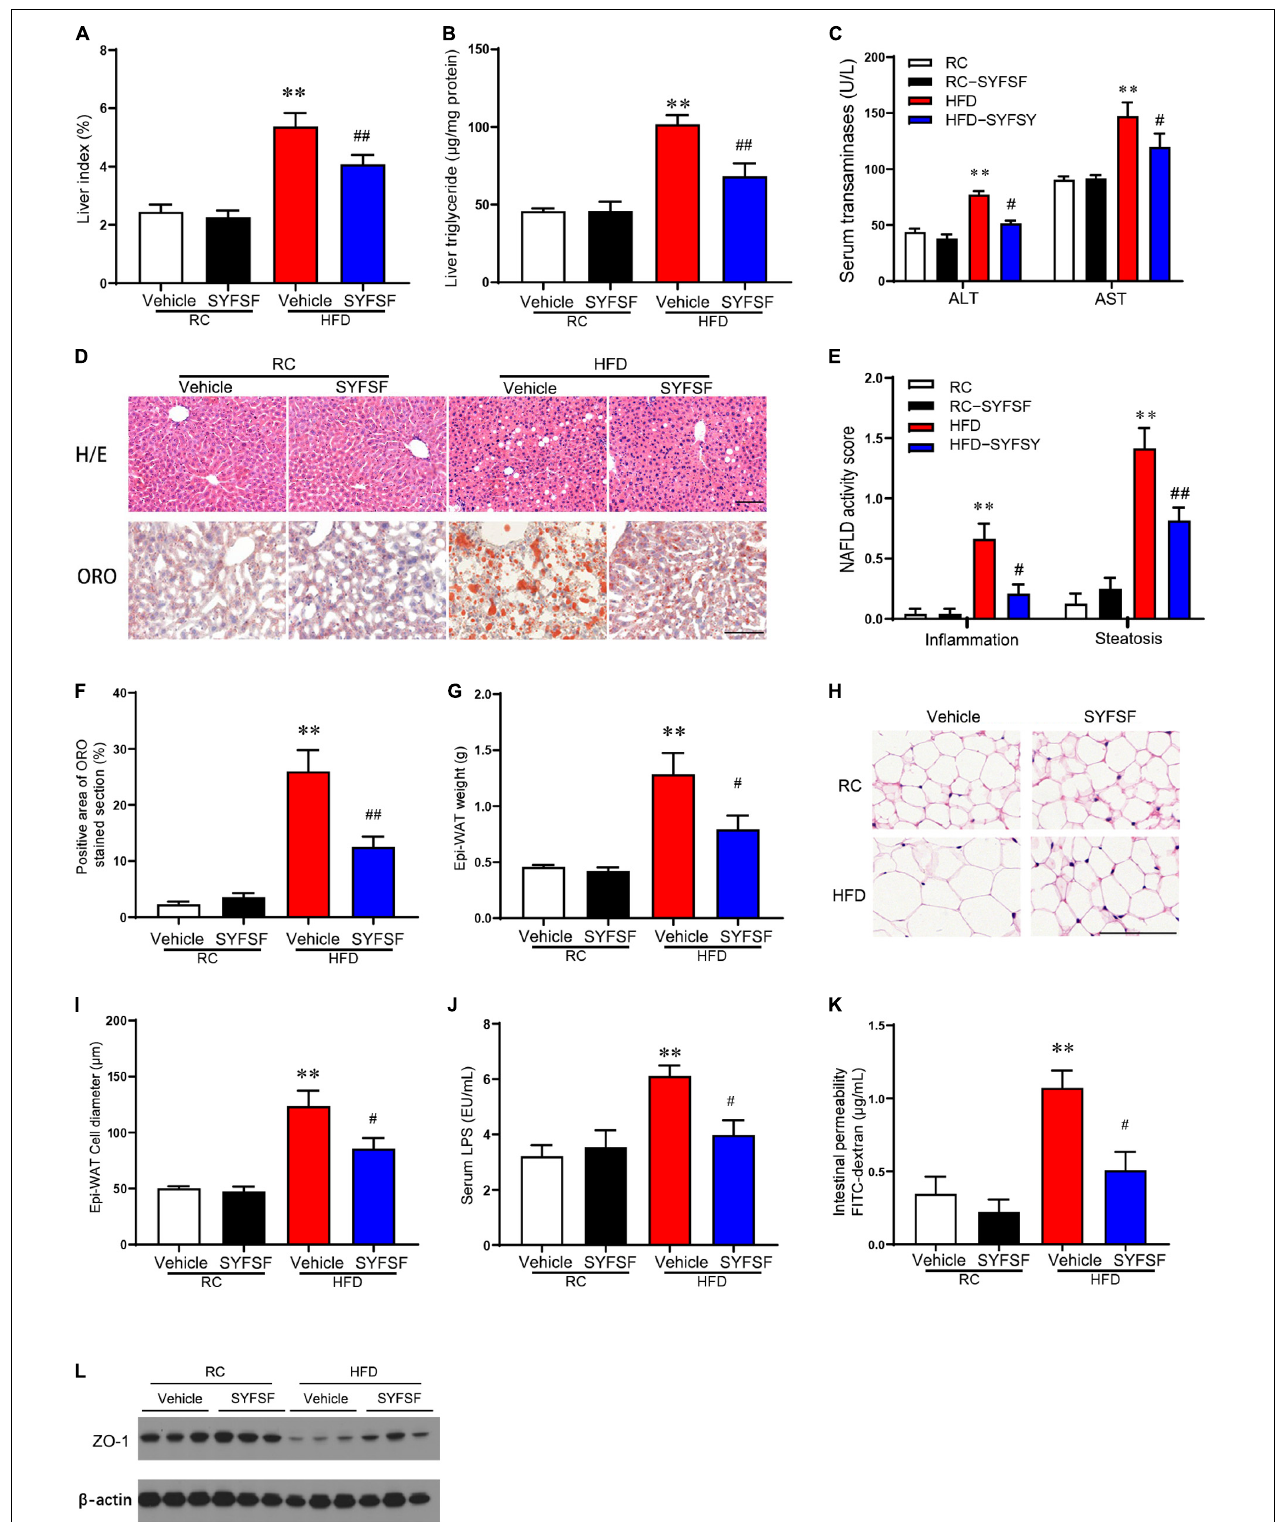
FIGURE 2 | SYFSF prevents fat accumulation in the liver and adipose tissue, and improved gut barrier function. (A) Liver index. (B) Liver TG. (C) Serum ASL and ALT. (D) HE staining and Oil Red O staining of sections from the liver. (E) NAFLD activity score. (F) Oil Red O staining. (G) Epi-WAT weight. (H) HE staining of sections from Epi-WAT. (I) Epi-WAT cell diameter. (J) Serum endotoxin. (K) Intestinal permeability. (L) Expression of ZO-1 in proximal colon. ∗∗ P < 0.01 vs. RC; ## P < 0.01, # P < 0.05 vs. HFD. n = 6 per group. Bar = 100 µ m.